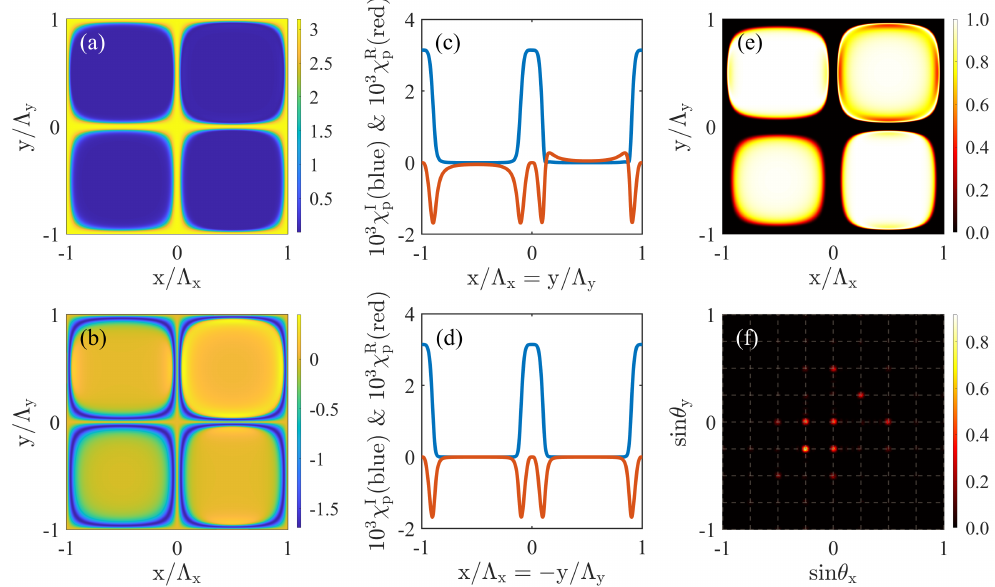
Figure 2. ( a ) Imaginary (10 3 χ I p ) and ( b ) real (10 3 χ R p ) parts of the probe susceptibility plotted against positions x and y together with their projections along the ( c ) x = y and ( d ) x = − y